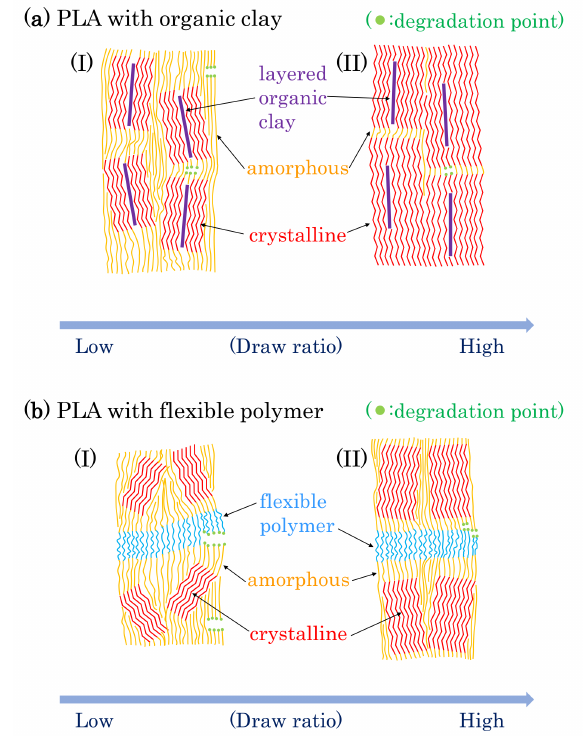
Figure 15. Proposed model of morphological changes in PLA fibers with drawing and